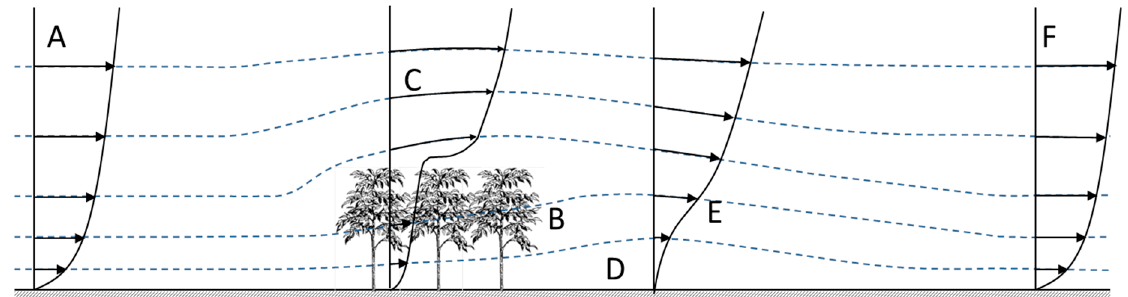
Figure 1. Schematic of wind flow around plants shown by streamlines (dotted line) and vertical profiles of mean wind speed. Symbols indicate ( A ): approach wind, ( B ): bleed flow, ( C ): displaced flow, ( D ): quite zone, ( E ): mixing zone, and ( F ): re-equilibration zone (recovered wind).